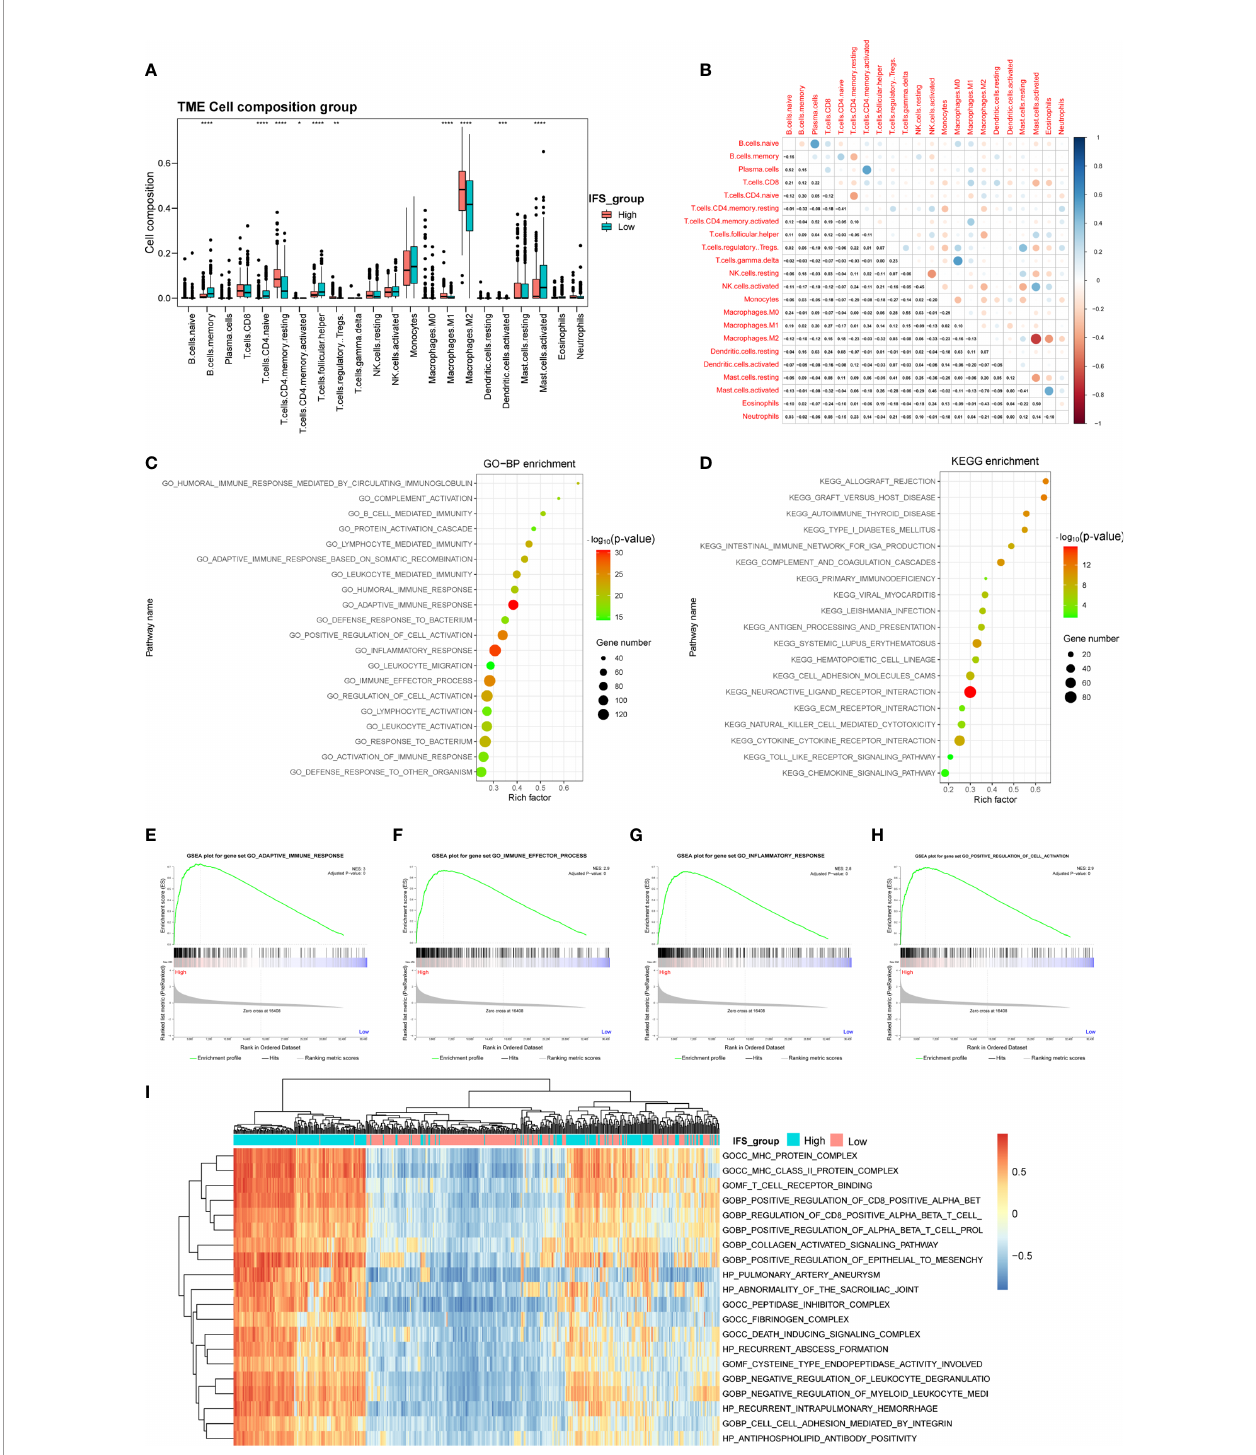
FIGURE 5 | Identi fi cation of the immune cell landscape and transcriptional characteristics between the high- and low-in fl ammatory signature groups in the TCGA cohort. (A) Comparison of the immune cell composition between the high- and low-in fl ammatory signature groups in the TCGA cohort. (B) Correlation of 22 types of immune cell subsets in the TCGA cohort. GO (C) , KEGG pathway (D) , GSEA (E – H) and GSVA (I) analyses of differentially expressed genes between the high- and low-in fl ammatory signature groups in the TCGA cohort. *p< 0.05; **p< 0.01; ***p < 0.001; ****p < 0.0001; Wilcoxon test was used to assess the signi fi cance of the immune cell